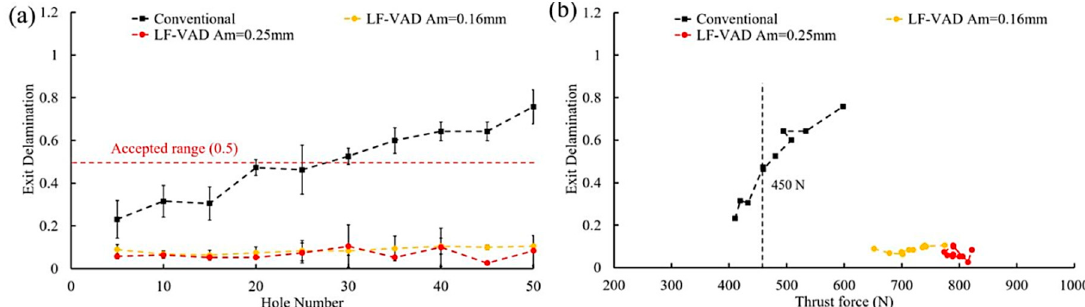
Figure 18. The effect of tool wear progress on the ( a ) exit delamination and ( b ) correlated thrust force at N = 37.68 m/min and f = 0.075 mm/rev.